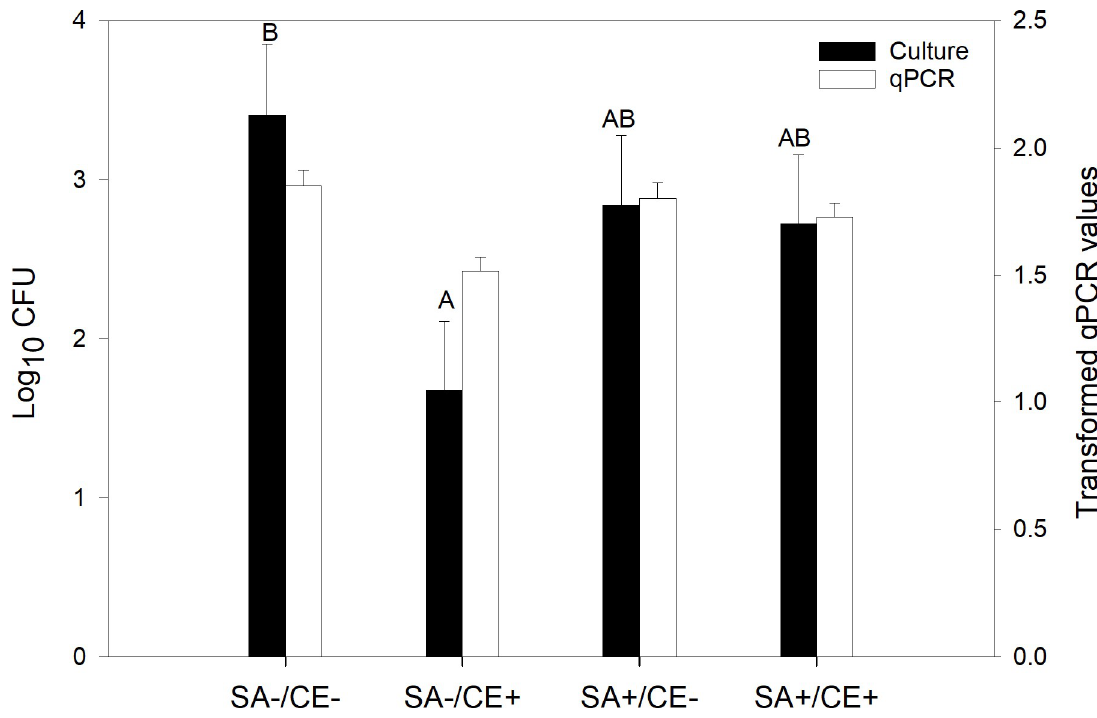
Fig 5. Enterotoxigenic Escherichia coli F4 shedding determined using culturing (black bars) and qPCR (white bars) in feces samples from piglets receiving a standard diet without chestnut extract (CE) nor sodium salicylate (SA) supplementation (SA-/CE-; N = 18), from piglets receiving a standard diet with CE and without SA supplementation (SA-/CE+; N = 18), from piglets receiving a standard diet supplemented with SA (SA+/CE-; N = 18), and from piglets receiving a standard diet supplemented with both CE and SA (SA+/CE+; N = 18). From days 0–4 post-infection, pigs from the SA+/CE-and SA+/CE+ groups were offered a daily dose of sodium salicylate (35 mg/kg BW per day, sodium salicylate, ReagentPlus 1 , S3007, Sigma-Aldrich Chemie GmbH; Buchs, Switzerland). From days 0–4 post-infection, pigs from the SA-/CE-and SA-/CE+ groups were offered a daily dose of tap water. The CE- diet was a control standard starter diet, which was formulated according to the Swiss feeding recommendations for pigs (Agroscope, 2017). The CE+ diet was a CE-supplemented diet in which the wheat straw in the CE- diet was substituted for with 2% CE (Silvafeed Nutri P/ENC for Swine; Italy). Data are expressed as log 10 (Colony Formant Units) for culturing and as transformed qPCR values according to: Y ¼ 3 (cid:0) where X represents the ng heat-labile toxin-DNA per g of feces dry matter for qPCR. P-values for SA × CE: P = 0.03 (culturing) and P = 0.19 for qPCR). A,B Bars carrying no common superscript differ at P < 0.05 for the culturing